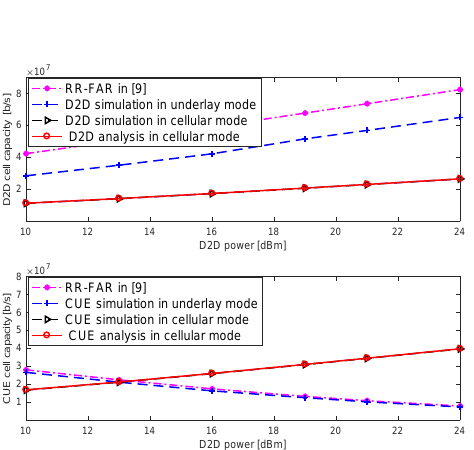
Fig. 3: D2D and CUE cell capacity as function of the D2D transmission powers in underlay mode scheme) and cellular mode ( CELLM ).